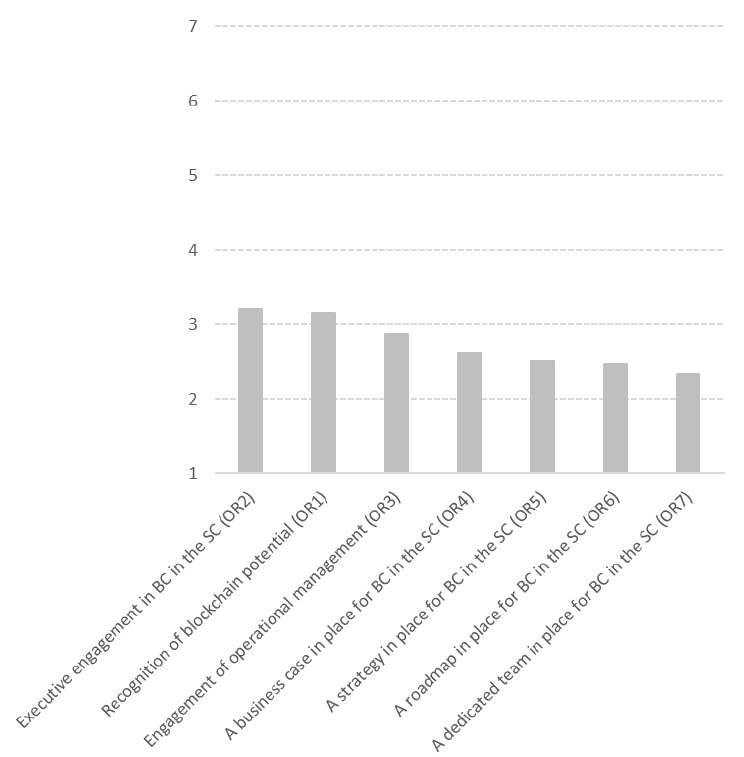
Figure 3. Average assessment of organizational readiness to blockchain adoption ( n = 190; 1 = “not at all”; 7 = ”to a very large